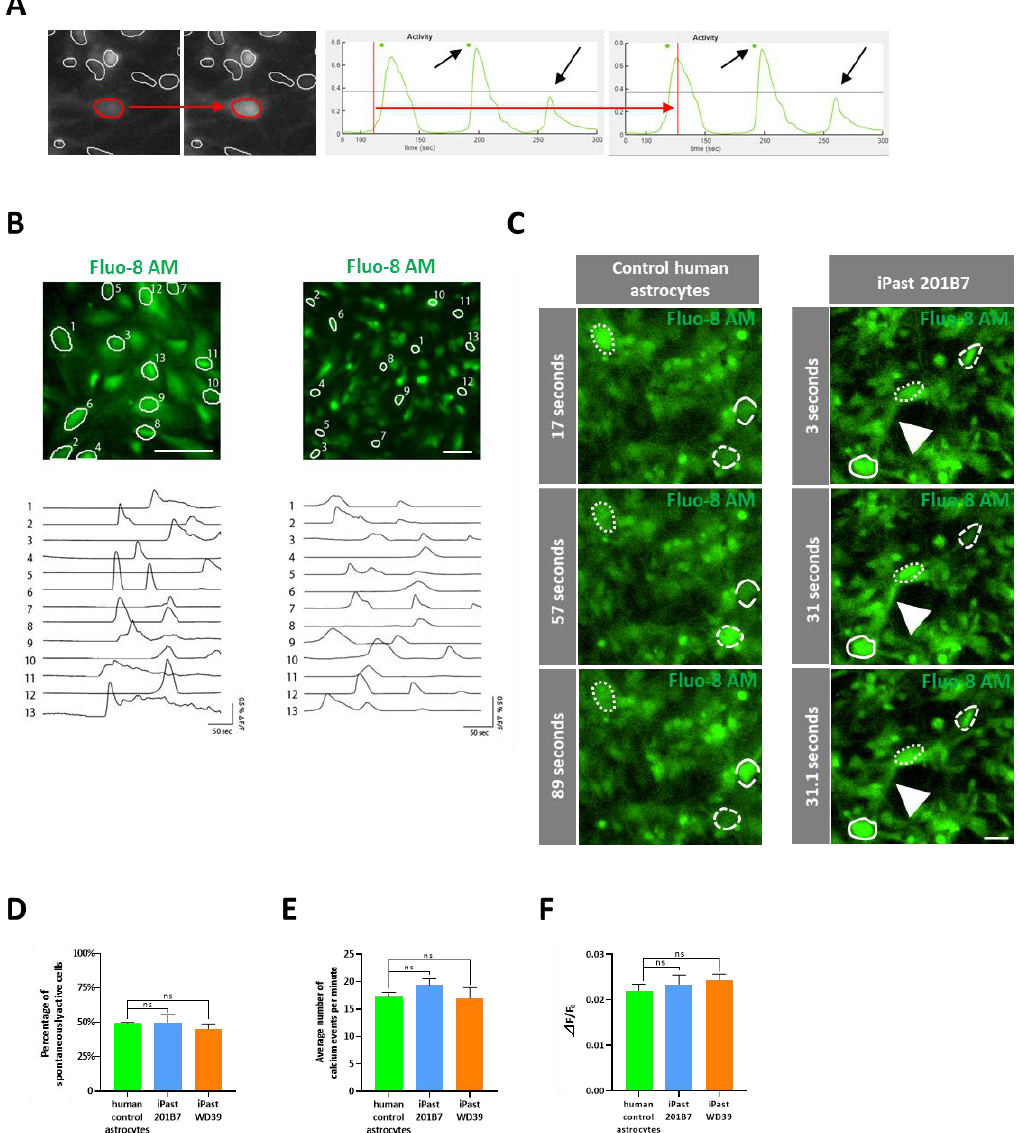
Figure 6. Spontaneous Calcium Fluctuations in Control Human Astrocytes, 201B7 and WD39 iPasts. ( A ) Representative ROI (red line) after automatic preprocessing by miniscope 1-photon-based calcium imaging signal extraction pipeline (MIN1PIPE) software, before and at the peak of fluorescence (left pictures). Illustration of the method of analysis: the determination of a threshold and duration of calcium fluctuation for each same event results in considering 2 calcium transients (green dots) rather than 3 peaks (black arrows) (right panels). ( B ) Representative calcium transients in human control-astrocytes (left) and iPasts (right). Time traces of corresponding cells delineated with white outlines. Scale bars: 20 µ m. ( C ) Representative experiments of Fluo-8 AM-stained human control astrocytes and 201B7 iPasts at di ff erent time points. The dotted circles indicate calcium transients captured during the acquisition, while white arrowheads point to a transient calcium fluctuation along an intercellular process. Scale bar: 10 µ m. ( D ) Percentage of spontaneously active cells in human control-astrocytes, 201B7 iPasts and WD39 iPasts. ( E ) Average number of calcium events per minute in human control-astrocytes, 201B7 iPasts and WD39 iPasts. ( F ) Average variation of calcium transients amplitude for human control-astrocytes, 201B7 iPasts and WD39 iPasts. Data shown are represent mean ± SEM. n = 3 passages. Statistical test: Mann-Whitney test. ns stands for non significant.